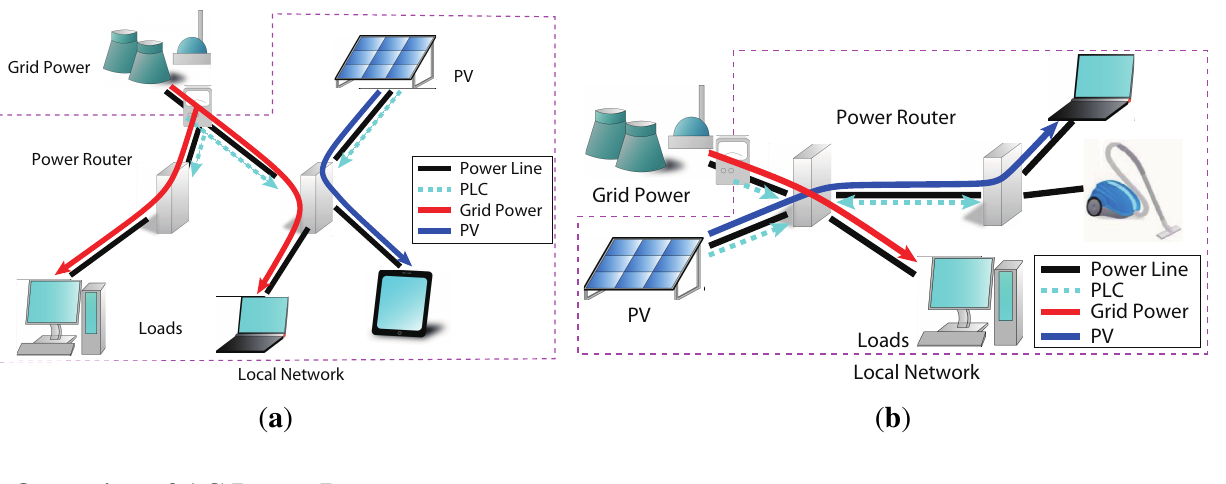
Figure 3. Elemental configurations of the network: ( a ) parallel configuration of power routers; and ( b ) series configuration of power